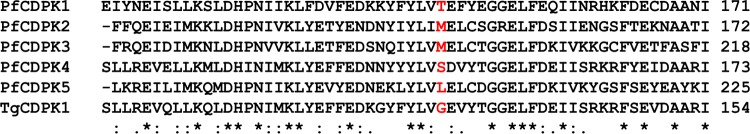
Protein sequence alignment highlighting gatekeeper residues in Plasmodium falciparum CDPKs and Toxoplasma gondii CDPK1. The gatekeeper residues shown in red are based on the glycine residue at position 128 of TgCDPK1 (17). Methionine in PfCDPK2 and -3 (PlasmoDB accession numbers PF3D7_0610600 and PF3D7_0310100, respectively) and leucine in PfCDPK5 (PlasmoDB accession no. PF3D7_1337800) are large gatekeeper residues compared to threonine in PfCDPK1 (PlasmoDB accession no. PF3D7_0217500). TgCDPK1 and PfCDPK4 (PlasmoDB accession no. PF3D7_0717500) have glycine and serine, respectively, which are smaller than threonine.